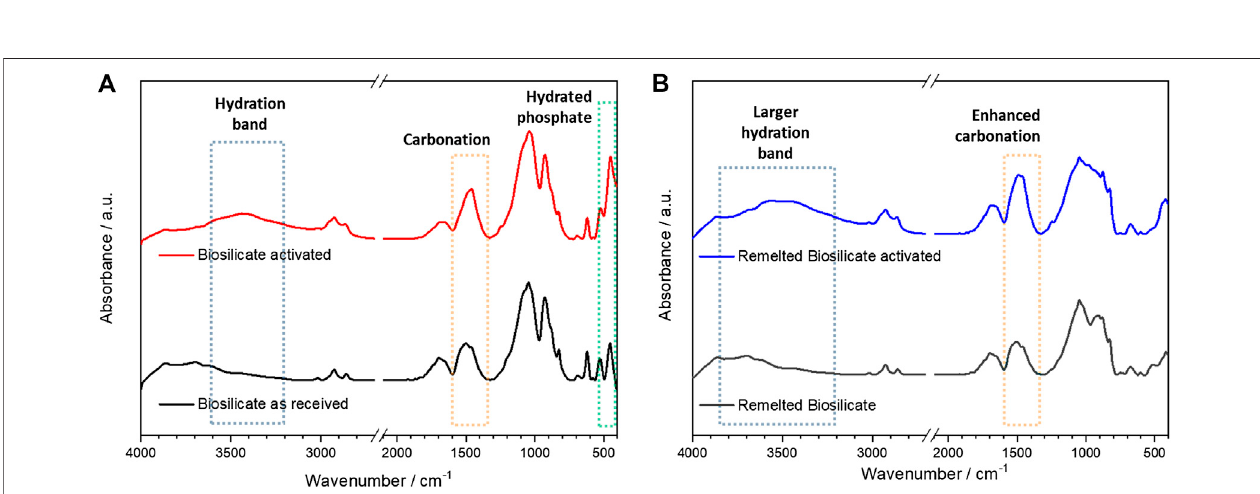
FIGURE 5 | Assessment of activation by comparing infrared spectra, before and after activation: (A) as received Biosilicate ® powders; (B) amorphous powders.